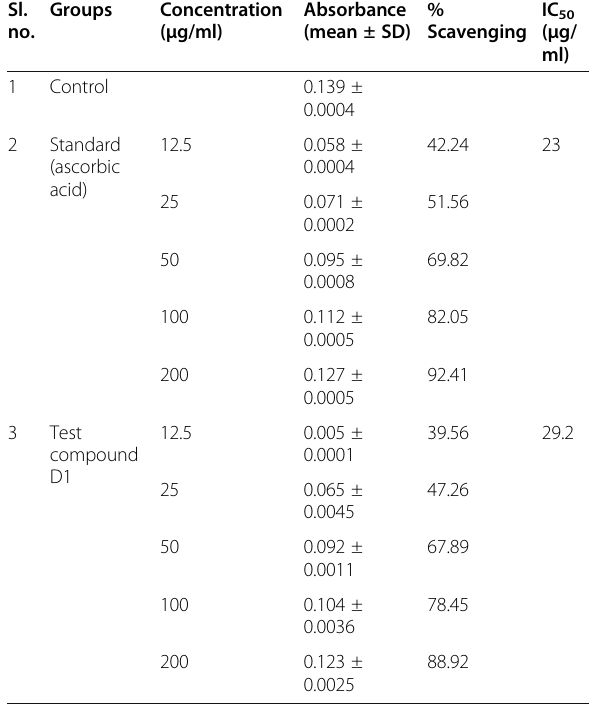
Table 5 Compound D1 exhibited antioxidant activity in a dose dependent